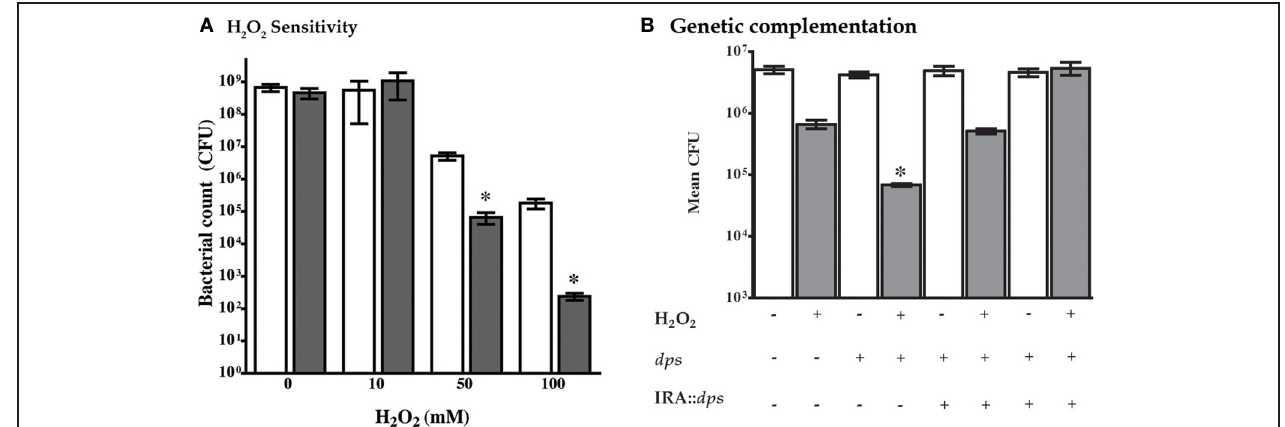
FIGURE 2 | Mutation of dps sensitizes NTHi 86-028NP dps to hydrogen peroxide. (A) Comparison of resistance of NTHi 86-028NP (white bars) and NTHi 86-028NP dps (shaded) to hydrogen peroxide. Both strains were suspended to equivalent density (10 8 CFU/ml) in PBS and treated with the indicated concentration of H 2 O 2 for 30min, after which survival was measured by plate-count. Values are means of six independent replicates;